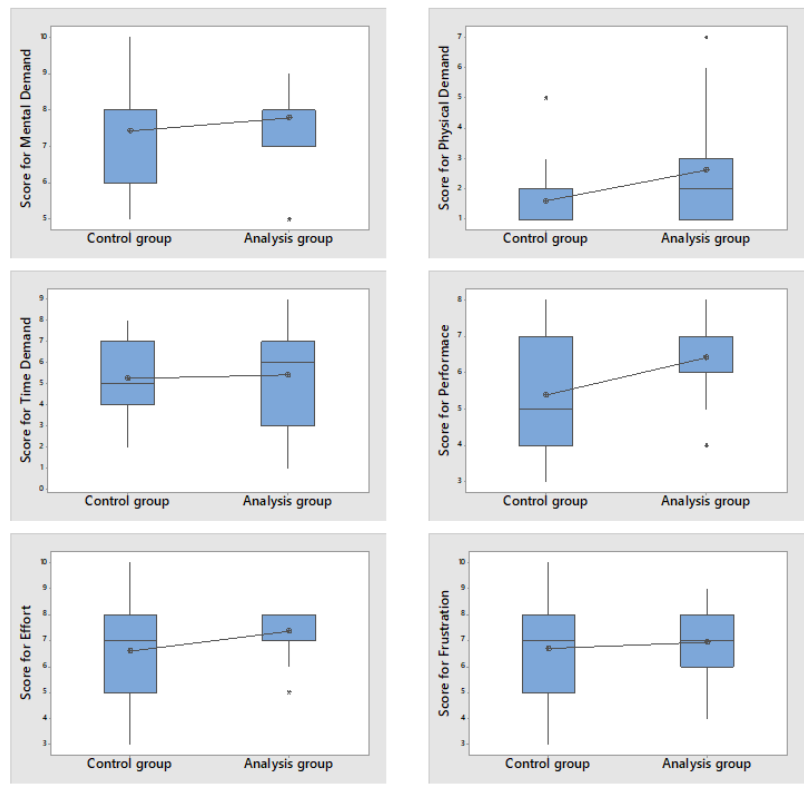
Figure 8. Boxplots of the answers gathered for each parameter (see Table 3) of the submitted